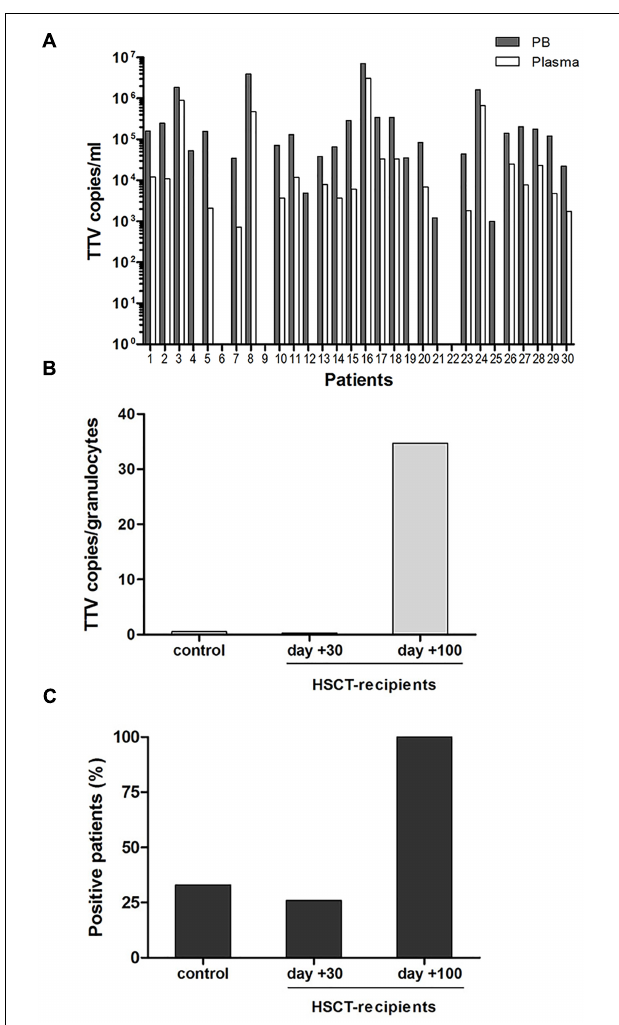
FIGURE 4 | TTV in peripheral blood and granulocytes in the pediatric control cohort. (A) Copy numbers of TTV in peripheral blood and plasma of 30 non-oncological control patients. (B+C) Comparison between the control group and the HSCT recipients until days +30 and +100. (B) TTV copies per granulocyte (CD15 + cells), (C) patient numbers displaying TTV positive